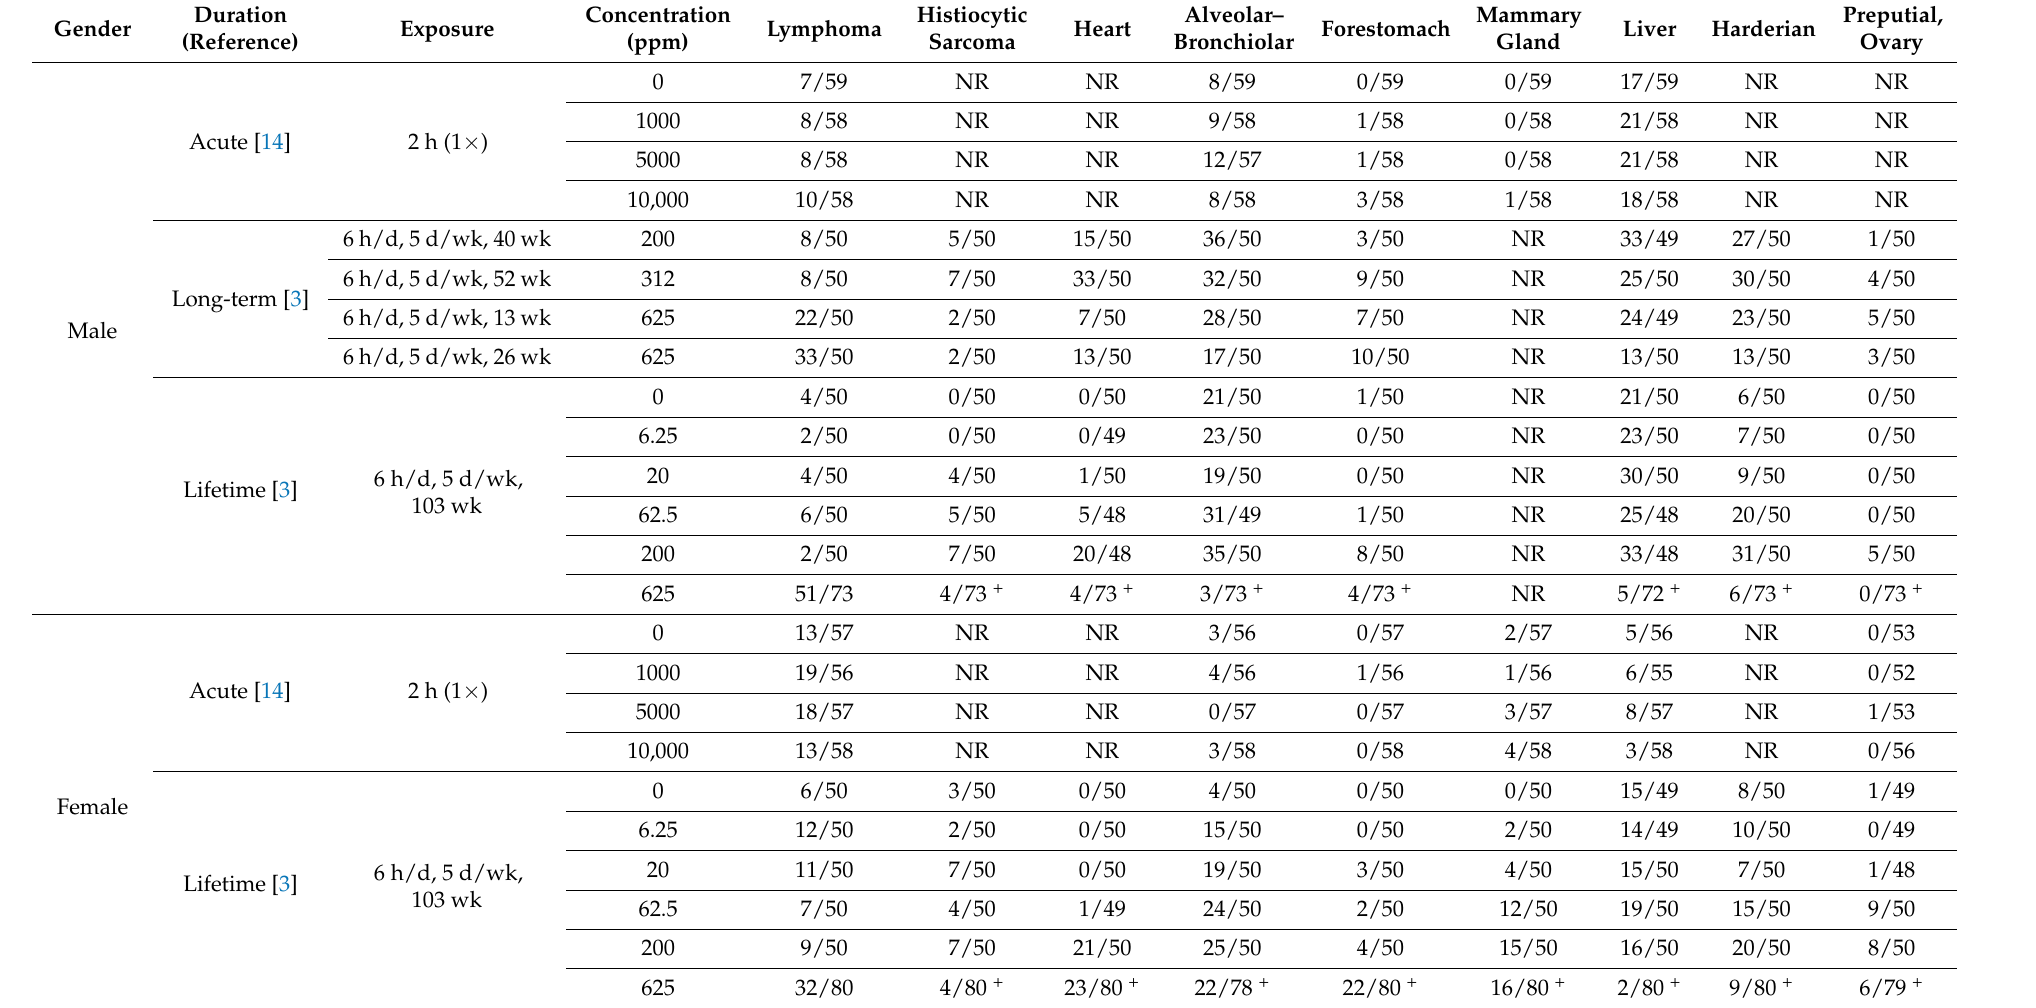
Table 2. Mouse tumor data following inhalation exposure to